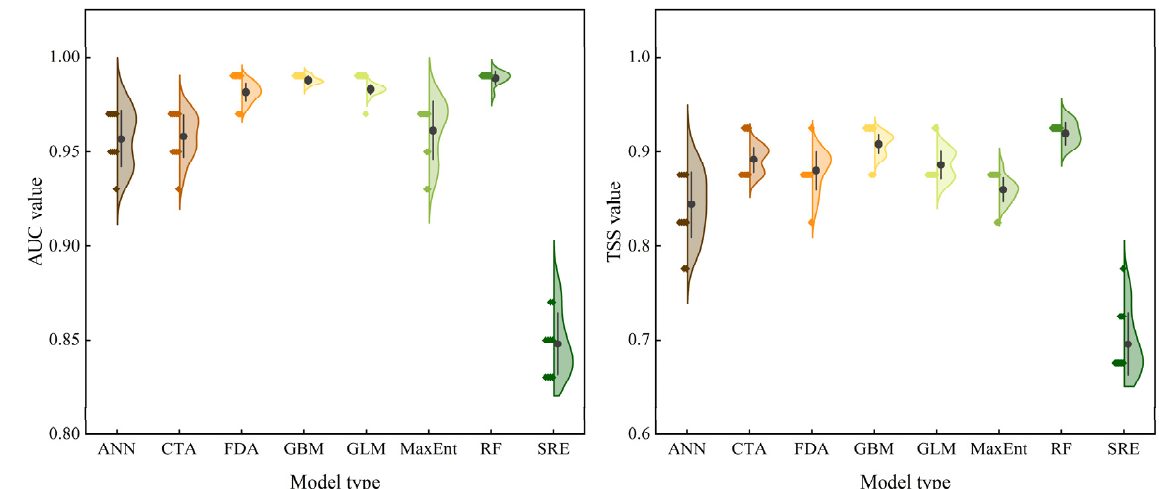
Figure 2. Evaluation indices of species distribution models (ROC: receiver operating characteristic,